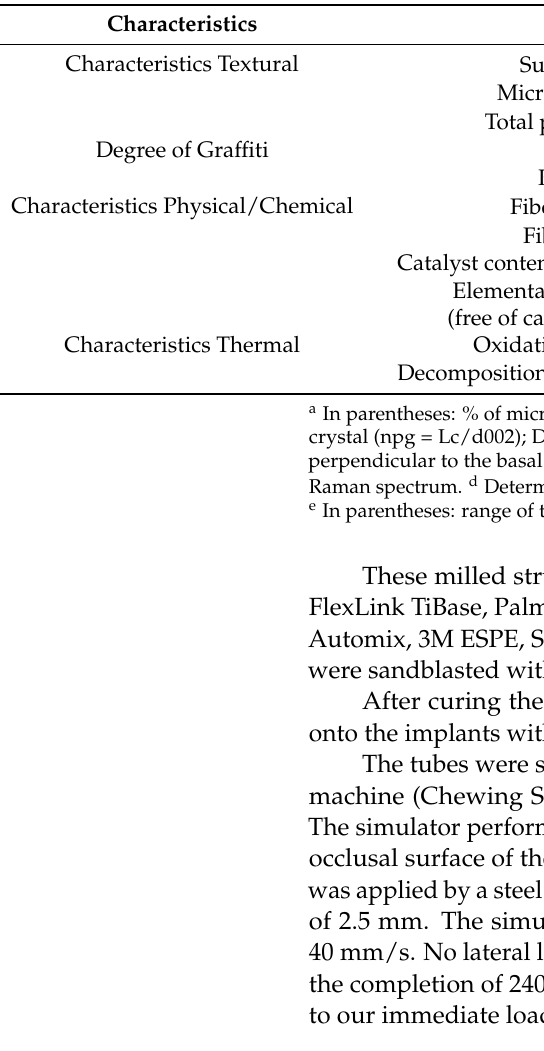
Table 2. Main characteristics of graphene